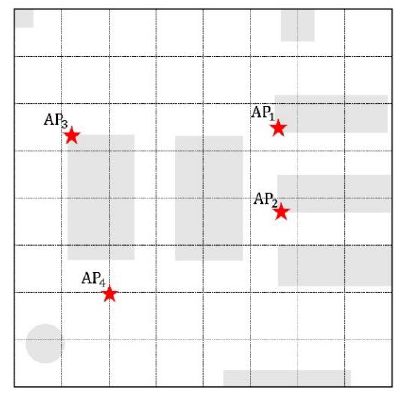
Figure 10. The plan of the experiments area.